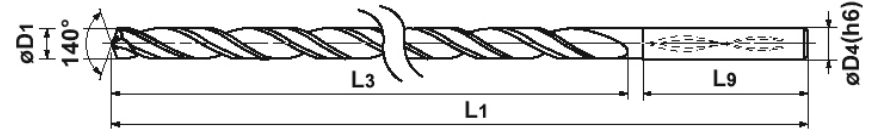
Figure 3. Cutting tool geometry.